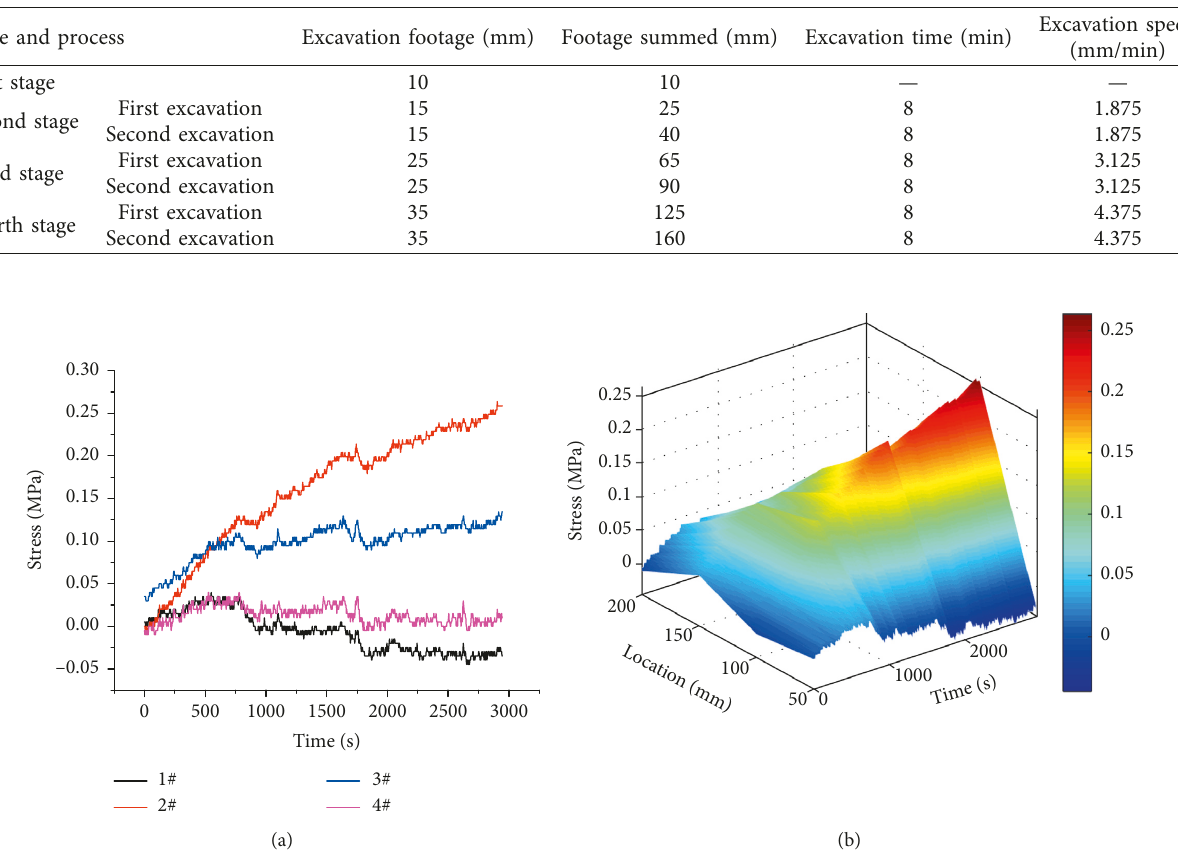
Figure 3: Schematic diagram of the excavation scheme. Note. v the time of each excavation; t 3 is the waiting time of the excavation shift; and t 4 is the waiting time of the overhaul shift.